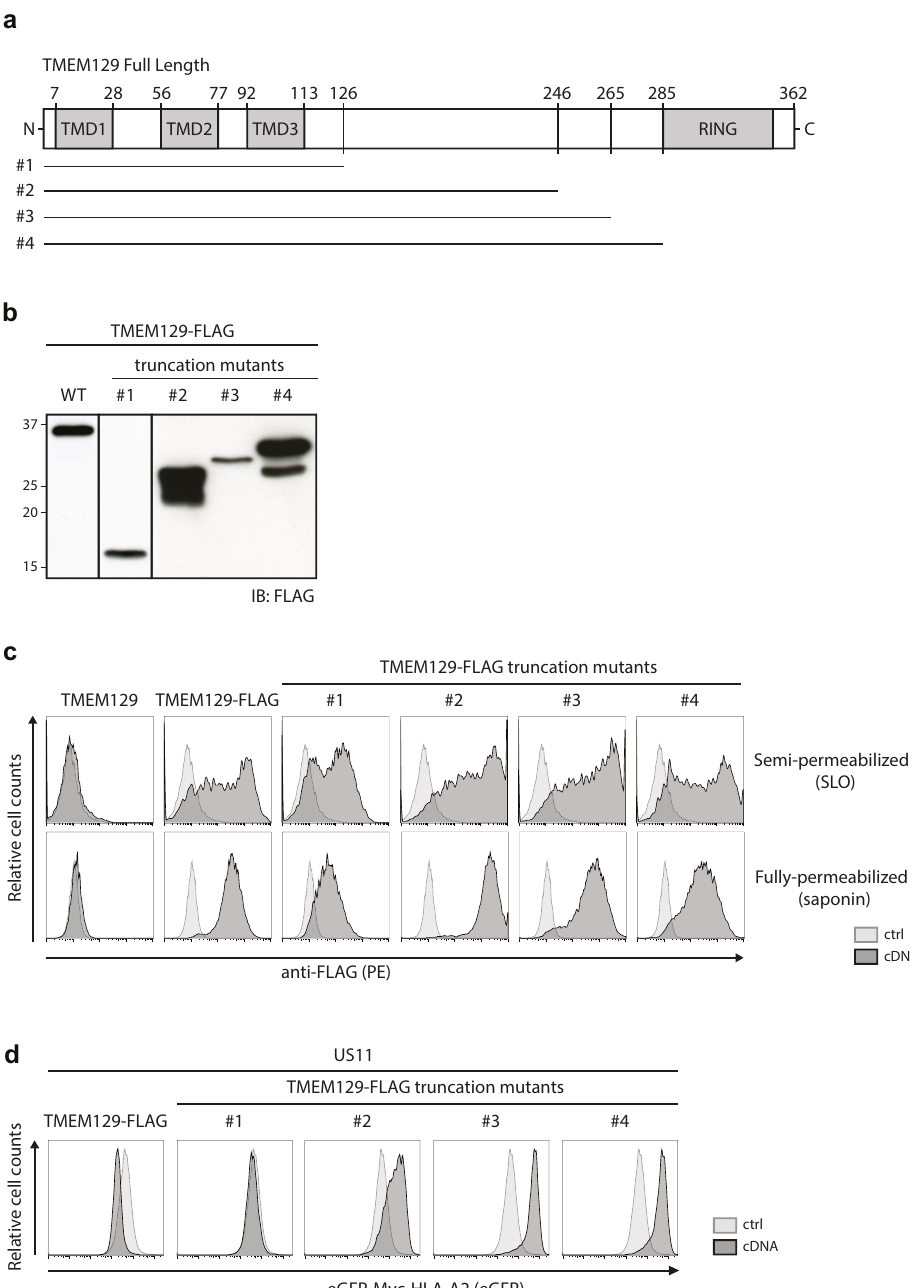
Figure 3. The cytosolic tail of TMEM129 is essential for activity. ( a ) Schematic representation of TMEM129 truncation mutants; ( b ) Truncation mutants of TMEM129 were expressed in U937 cells, after which the lysate was prepared and subjected to immunoblotting using a FLAG-reactive antibody. The full-length TMEM129-FLAG protein is indicated as wild-type (WT); ( c ) TMEM129 truncation mutants are properly inserted in the ER membrane. U937 cells expressing TMEM129-FLAG truncation mutants were semi-permeabilized using SLO, or fully-permeabilized using saponin. The C-terminus of the truncation mutants was detected using a FLAG-reactive antibody, after which flow cytometric analysis was performed; ( d ) Deletion of the entire TMEM129 cytosolic tail interfered with US11-mediated HLA class I downregulation whereas deletion of the RING domain resulted in a dominant-negative phenotype. Indicated truncation mutants of TMEM129-FLAG were expressed in U937 cells, co-expressing eGFP-Myc-HLA-A2 and HCMV US11. Flow cytometric analysis was performed to assess the total levels of eGFP-Myc-HLA-A2. Experiments were performed three times, of which one representative experiment is